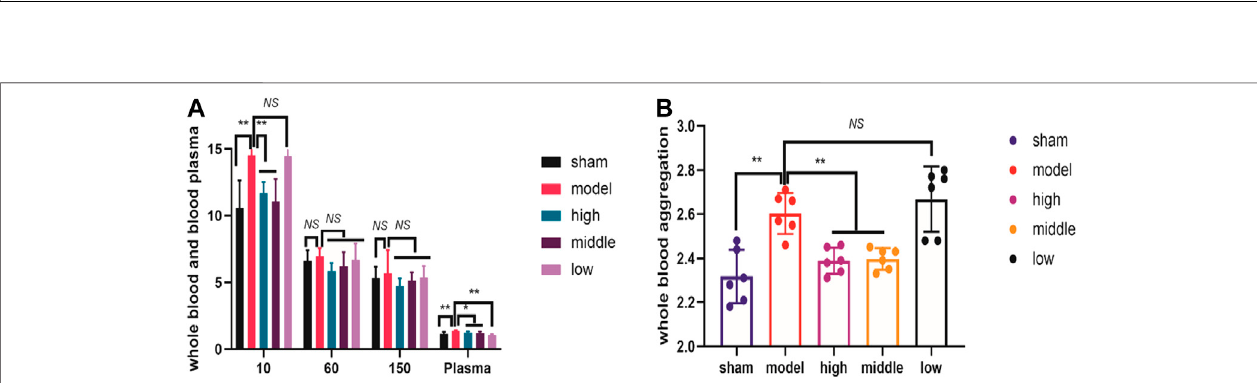
FIGURE 2 | THCQ attenuates brain injury and improves hemorheology indexes after intracerebral hemorrhage (ICH). ICH was induced in SD rats by injection of collagenase.Hemorheology tests wereperformedtoevaluate thereduction ofthe wholeblood viscosity at lowshearand the plasmaviscosityinrats receivingvehicleor THCQ at day 3 after injection of collagenase (right) (A) . Hemorheology tests were performed to evaluate the extent of RBC aggregation (aggregation index) in rats receiving vehicle or THCQ at day 3 after injection of collagenase (right) (B) .